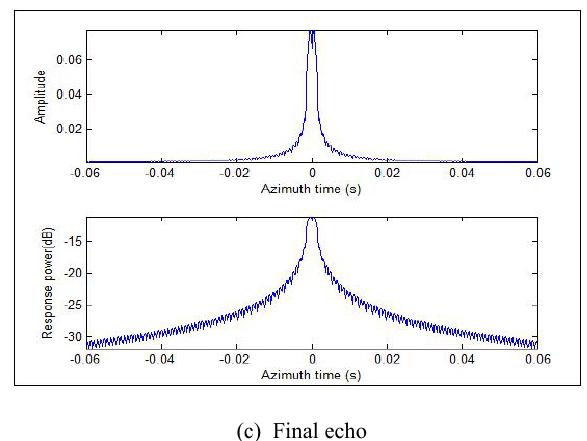
Figure 3. Simulation results of the echoes before and after